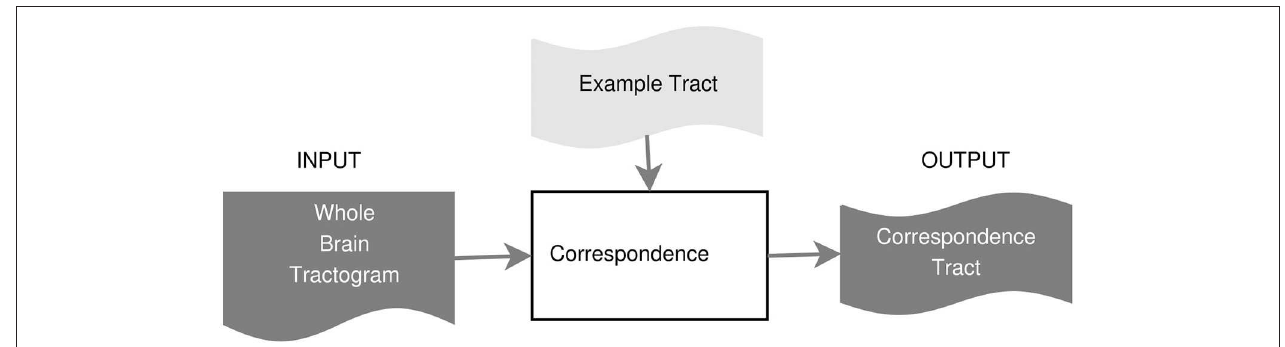
FIGURE 3 | Tract segmentation from a single